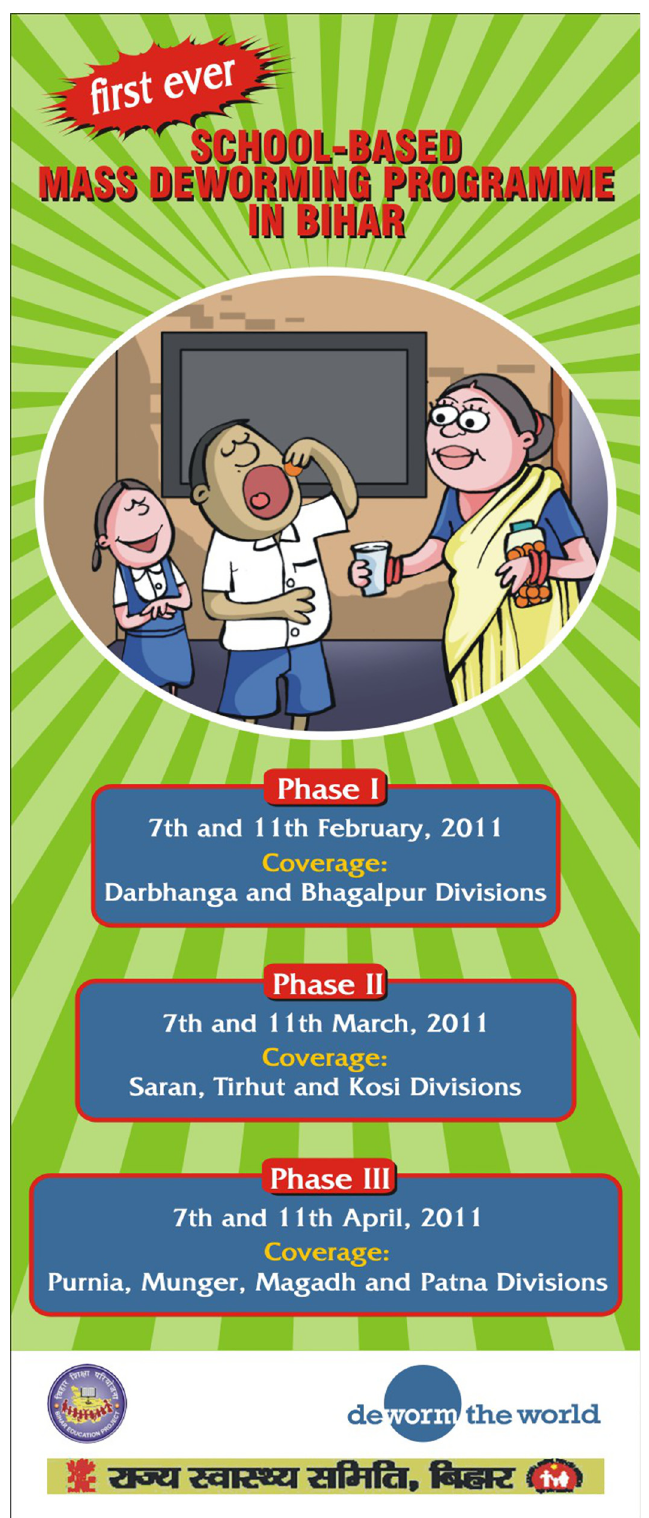
Fig 4. Examples of community sensitization and awareness posters. Phase-wise information on the programme. The posters were also translated into Hindi and demonstrate the level of dissemination of